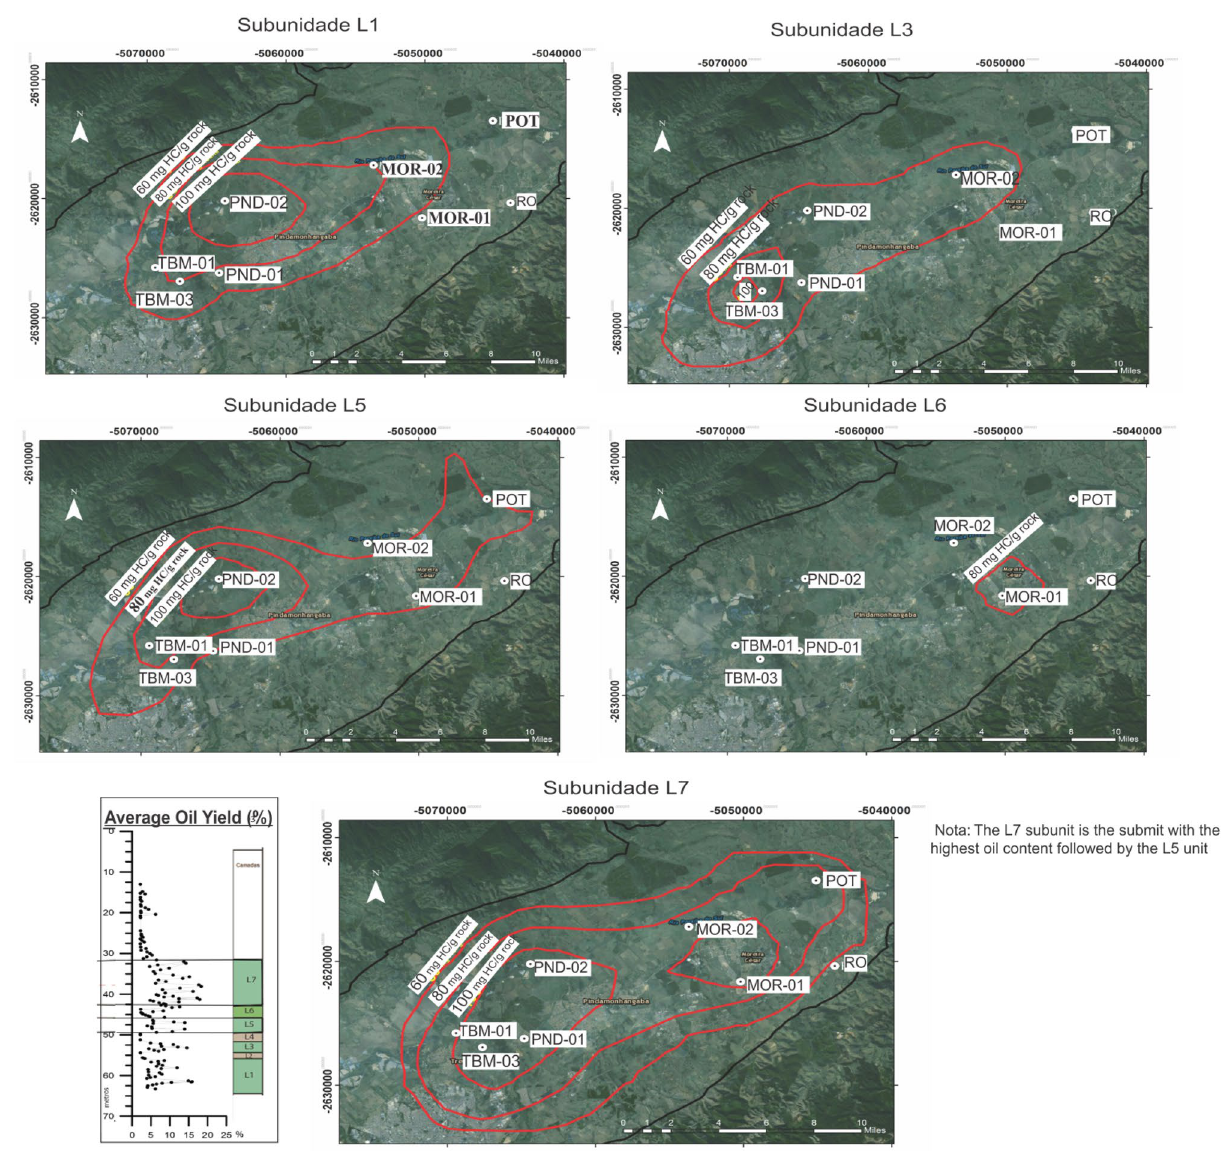
Fig. 9 The chemostratigraphic units and the isolines for yields of 60, 80 and 100 mg HC/g rock (red). It can be observed that the isolines of greatest yield (100 mg) surround wells TMB-03-SP and PND-02-SP,